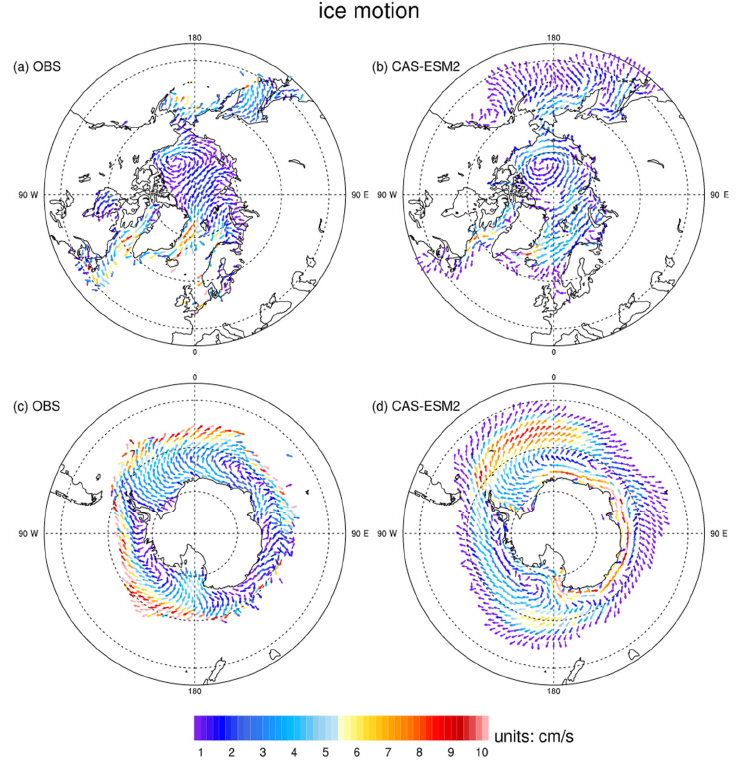
Figure 10. Annual mean ice motion direction (vector) and speed (shading) based on NASA NSIDC observations [40] for ( a , c ) 1979 − 2014 climatology and ( b , d ) CAS-ESM 2.0 historical simulations for ensemble mean of 1979 − 2014 in Northern Hemisphere (upper panel) and Southern Hemisphere (lower panel).